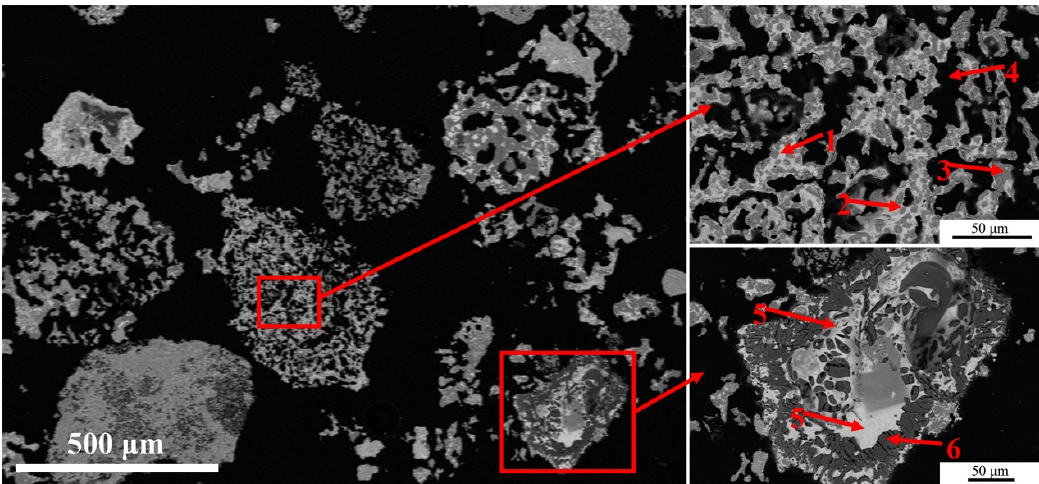
Figure 6. Backscattered electron image showing the morphology of the zinc calcine reheated at 900 °C. 1–PbZnSiO 4 (light), 2–ZnFe 2 O 4 (grey), 3–Zn 2 SiO 4 (dark grey), 4–pore (black), 5–Pb 10 (SiO 4 ) 3 (SO 4 ) 3 F 2 (light), 6–CaSO 4 (dark).